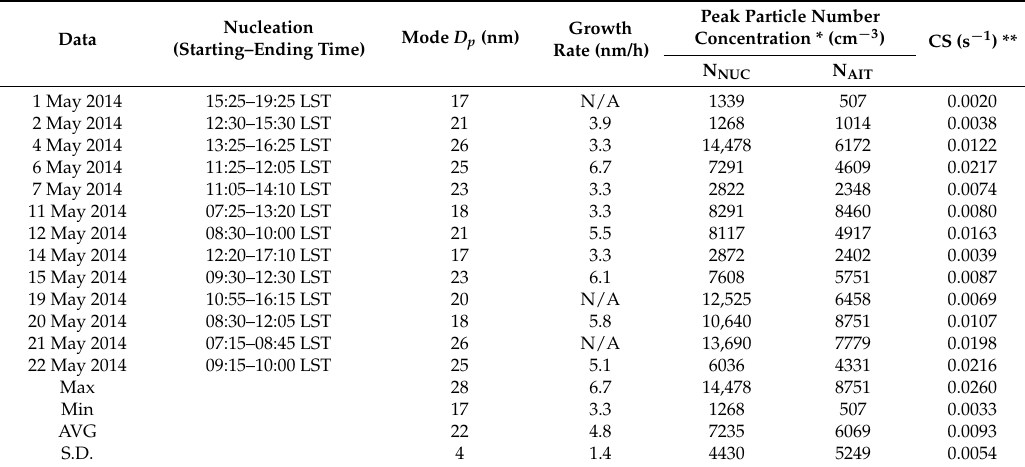
Table 2. Summary of NPF events at the suburban site of Xi’an from 1 to 25 May in